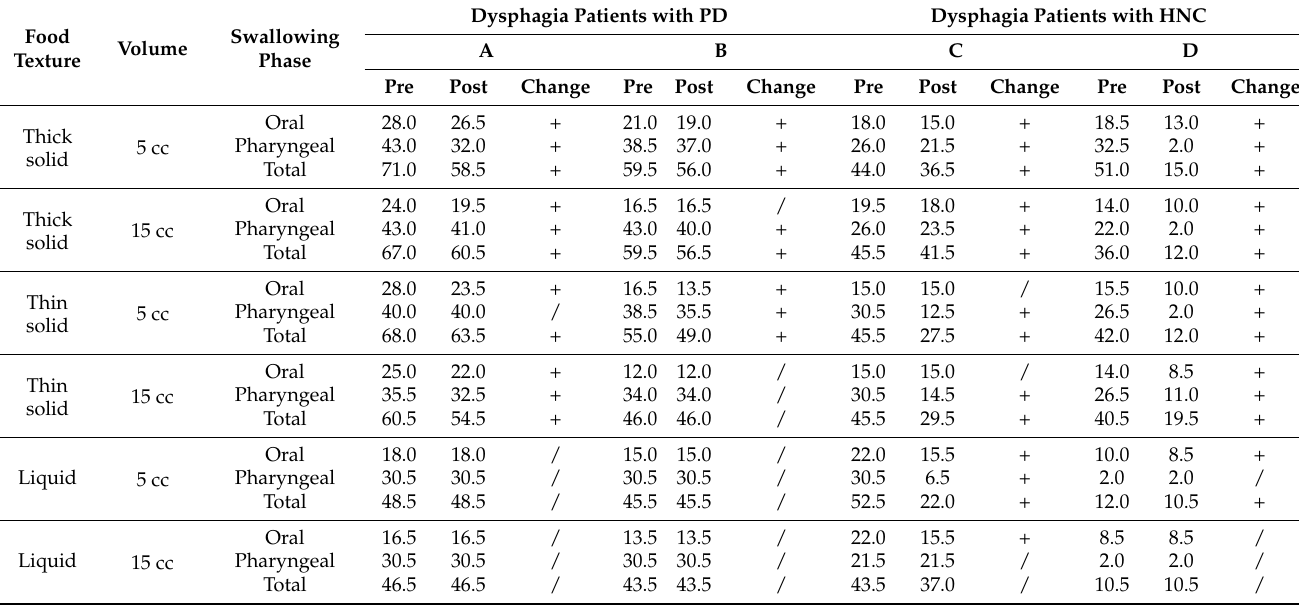
Table 2. Results of VDS measurements.